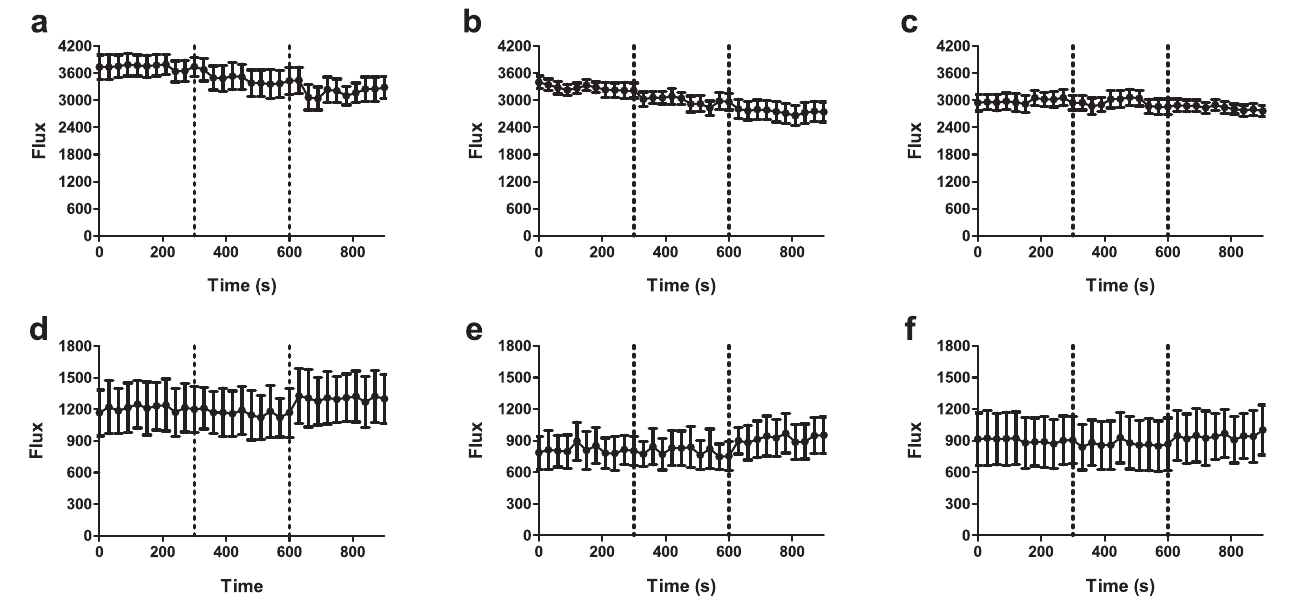
Figure 8. Vasoactive responses to GSK1016790A and vehicle in healthy and endotoxaemic WT mice. Baseline mesenteric blood flow was recorded for 5 min in naïve ( a – c ) and endotoxaemic ( d – f ) mice, 24 h after injections of LPS. Vehicle (V; 2% DMSO in saline) was then administered as an aerosolised spray, followed by administration of GSK1016790A (G; 1 µM) 5 min later. Blood flow was recorded in ( a & d ) 1 st order, ( b & e ) 2 nd order and ( c & f ) 3 rd order mesenteric vessels. Data are presented as mean ± SEM. *p<0.05, area under the curve relative to baseline, 1-way ANOVA + Bonferroni post-hoc test (n =